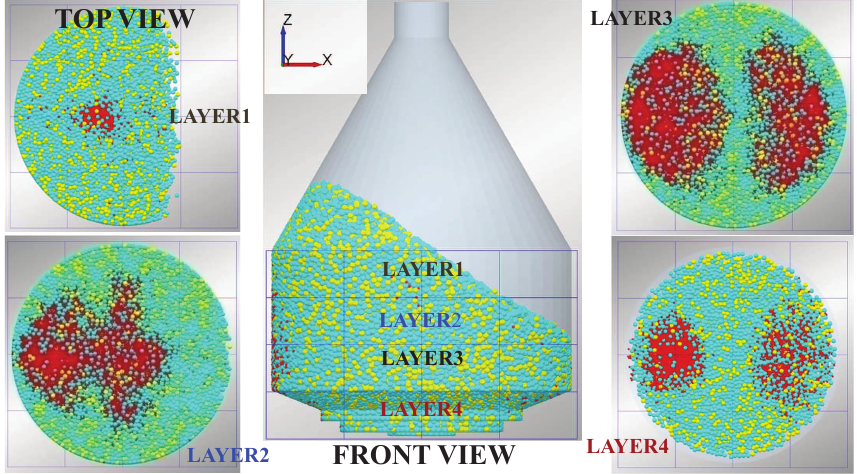
Figure 3. Discretization of the blender into different zones (grid